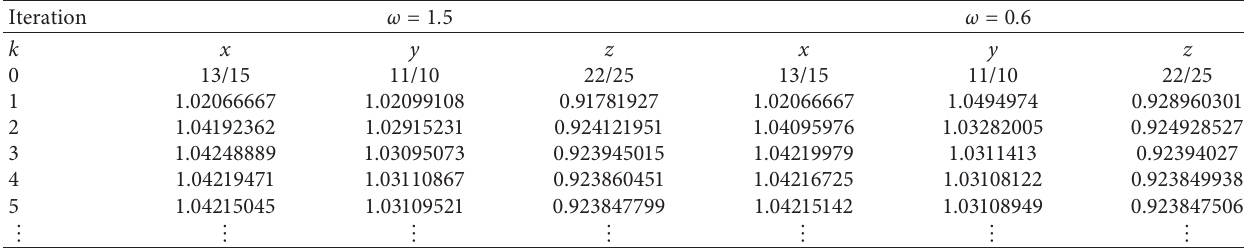
Table 2: Approximate solution of equation (35) using the proposed method (10) and